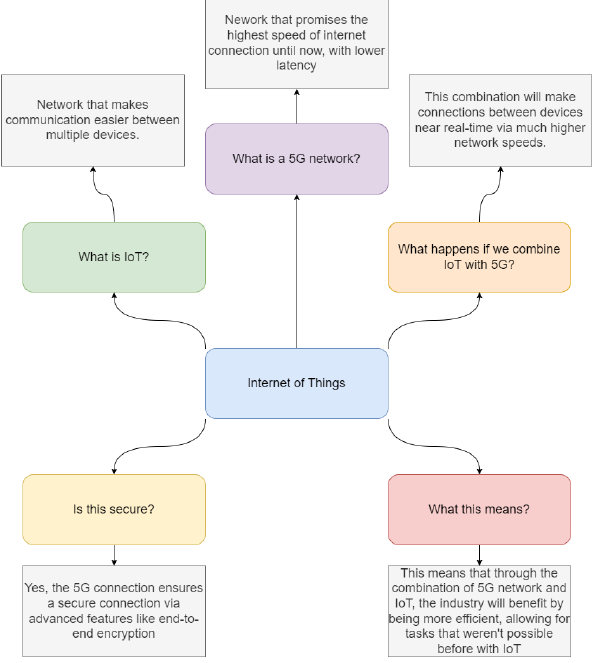
Figure 7. Defining 5G and features that are essential for the Internet of Things